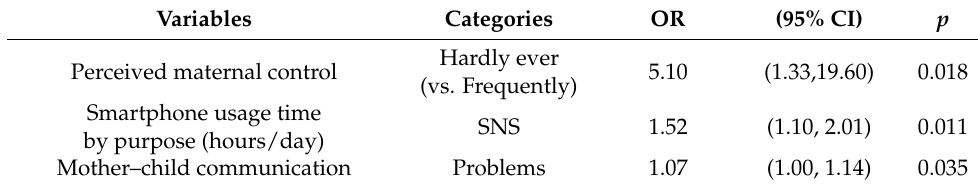
Table 4. Maternal factors affecting PSU in school-age